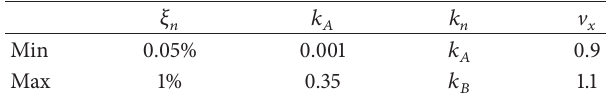
Table3:BoundsfortheMonteCarlosimulationsfor V ̸= 1 and 𝑙 = 1